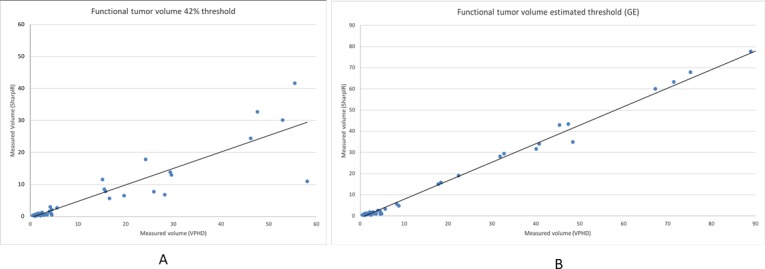
Diagrams of FTV with 42% threshold and estimated threshold.(A) FTV plotted for all lesions in VPHD and SharpIR clinical ACE-PET/CT, where ROIs are delineated with 42% threshold algorithm, and (B) estimated threshold algorithm. The black line is the best fit regression line.